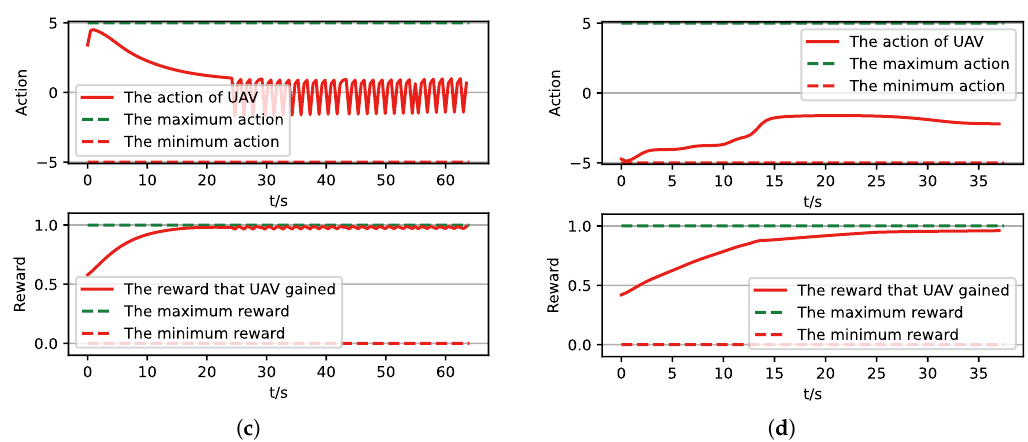
Figure 18. The parameters curve from MC experiments for the trained result of UER-DDPG. ( a ) The parameters curve of 1st experiment. ( b ) The parameters curve of 2nd experiment. ( c ) The parameters curve of 3rd experiment. ( d ) The parameters curve of 4th experiment.